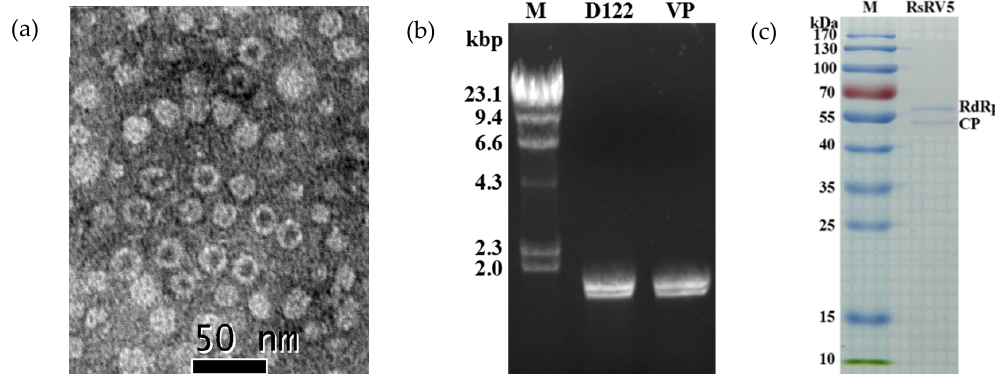
Figure 4. Viral particle traits in strain D122 of Rhizoctonai solani AG-1 IA. ( a ) Viral particles observed under TEM (negative staining). Particles were purified from mycelia of strain D122 (scale bars, 50 nm); ( b ) Agarose gel electrophoresis of dsRNAs (dsRNA-1 and dsRNA-2) extracted from mycelia of strain D122 and from viral particles (VP), respectively. M: molecular markers ( λ DNA digested with Hind III); ( c ) SDS-PAGE analysis of structural proteins from viral particles. The size of the Coomassie blue-stained protein was estimated by comparison with protein markers. kDa: Kilodaltons.